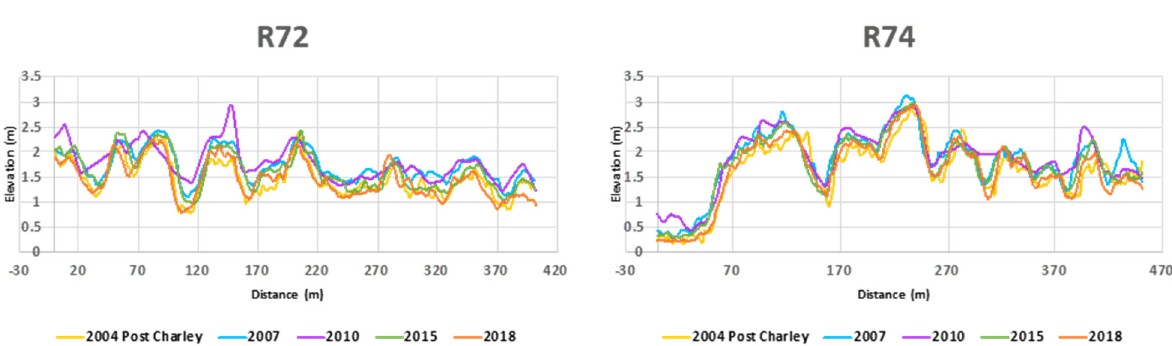
Figure 4. R72 and R74 elevation profiles with respect to NAVD88 of North Captiva Island for 2004 post-Charley through 2018.